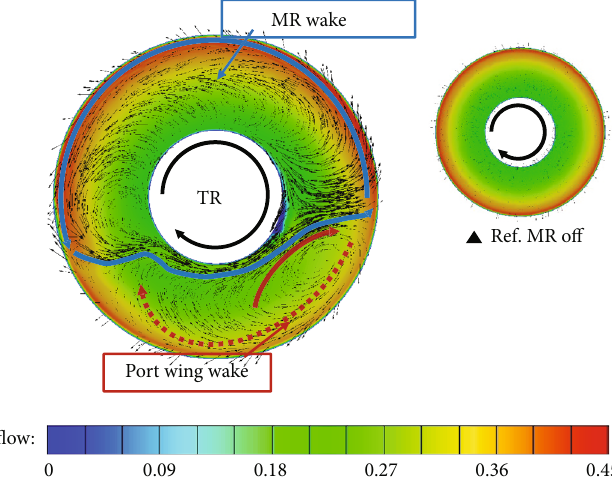
Figure 13: In fl ow contour with in-plane velocity vector in hovering fl ight.